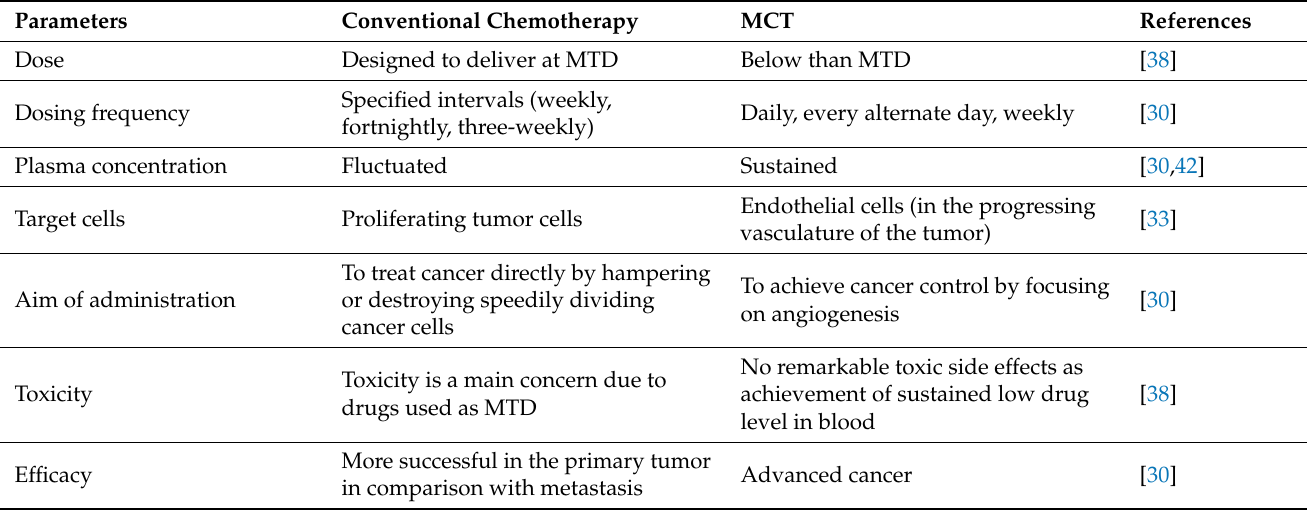
Table 1. Difference between conventional chemotherapy and